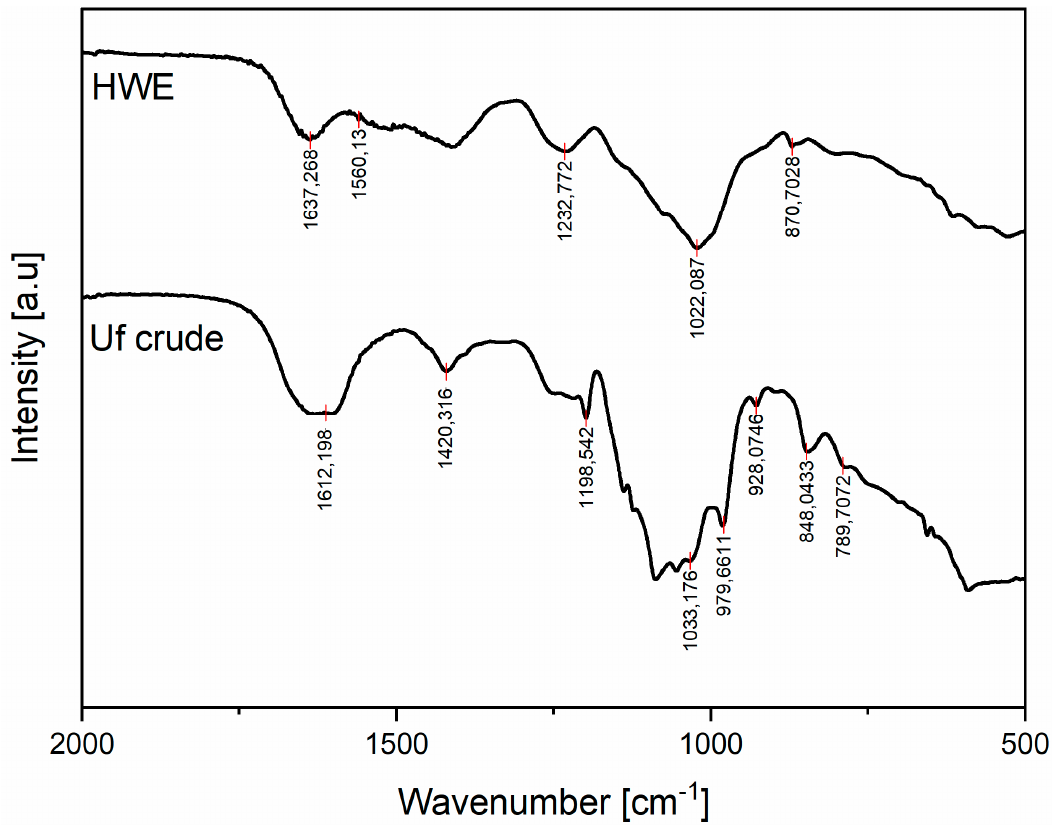
Figure 1. FTIR spectra of C. racemosa (HWE) and U. fasciata (crude ulvan) fractions.